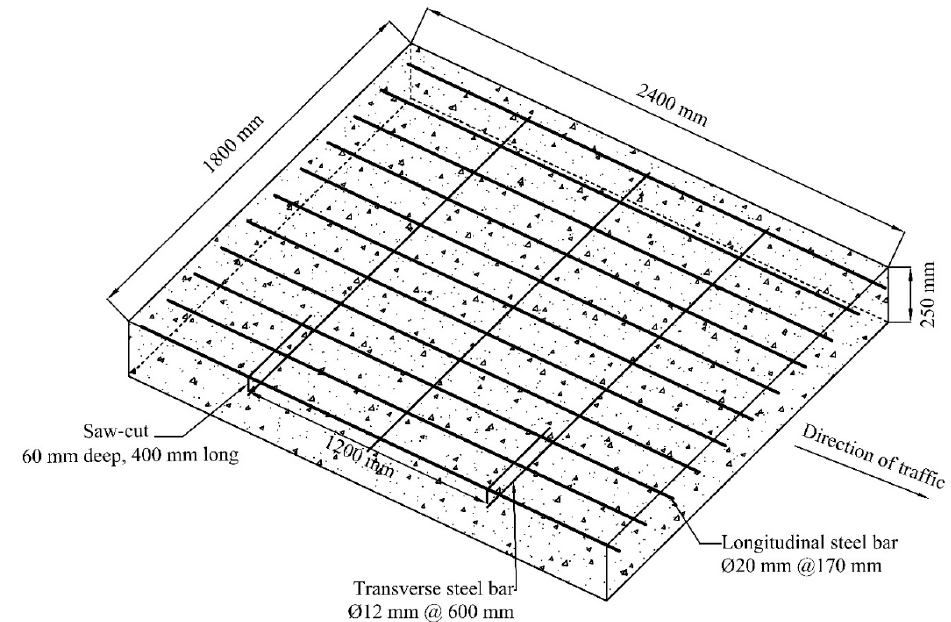
Figure 3. Geometry configuration of the CRCP segment.